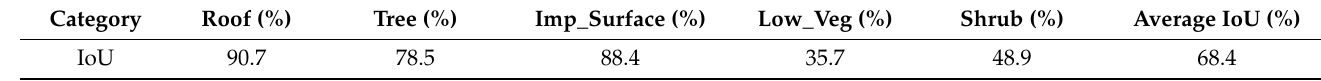
Table 5. IOU values of each classification.